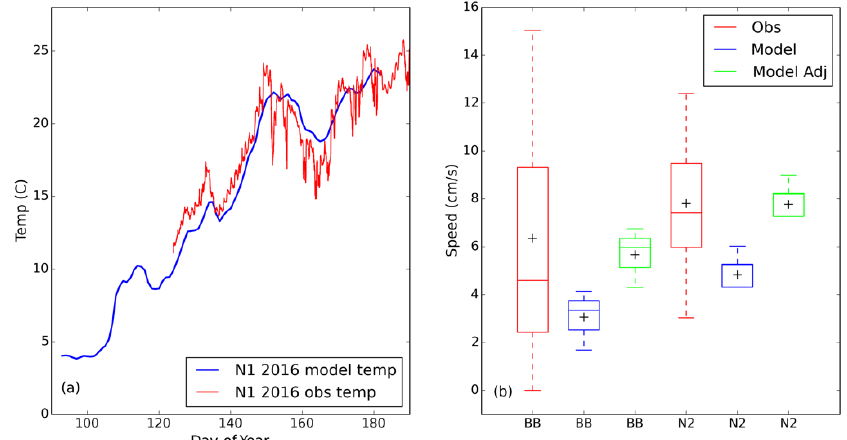
Figure 5. ( a ) Comparison of observed and modeled surface temperatures at Napanee (N1; Figure 1) and ( b ) observed drifter speeds captured at Big Bay (16 June 2017) and Napanee (24 June 2017) (BB and N2; Figure 1) compared to model speeds and model speeds adjusted by wind factor.